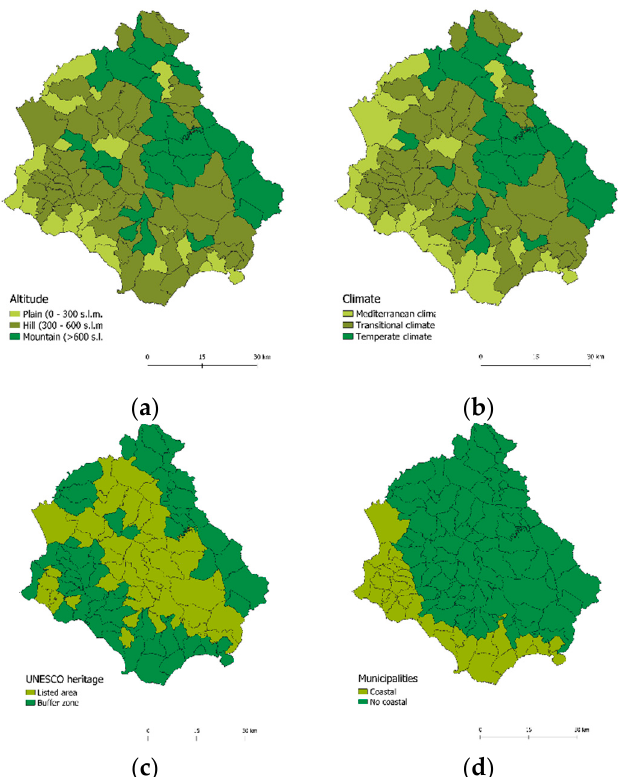
Figure 4. Spatial distribution in Cilento of altitude, climate, UNESCO heritage area, coastal/non ‐ coastal areas . Note: ( a ) Altitude distributions of plains, hills, and mountains in Cilento; ( b ) Localization of Mediterranean, transitional, and temperate climate in Cilento; ( c ) Evidence of UNESCO heritage area and buffer zone; ( d ) Division between coastal and non ‐ coastal areas in Cilento.